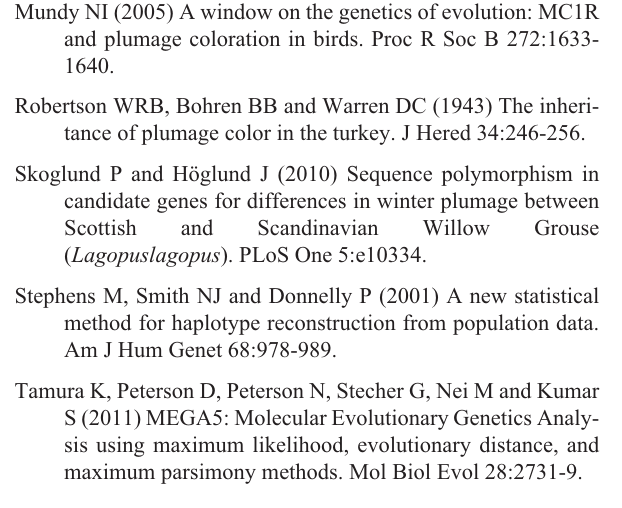
- Figure S1 –Turkey phenotypes used in the MC1R